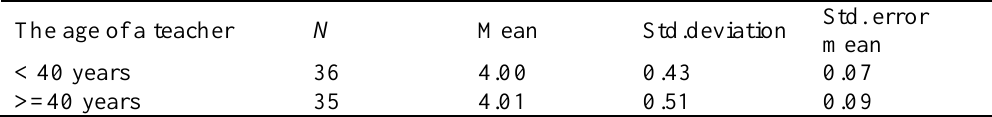
Mean Evaluation Scores Received from Students Participating in the Online Distance Learning Program, Categorised by Teaching Staff Age Groups The age of a teacher